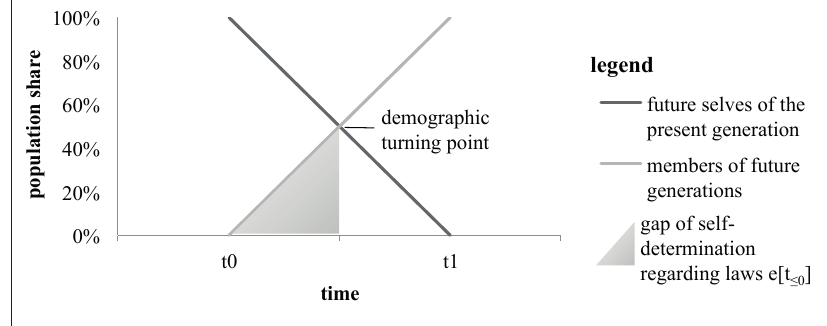
Figure 1: Gap of self-determination, applying the legalistic version of the all-affected